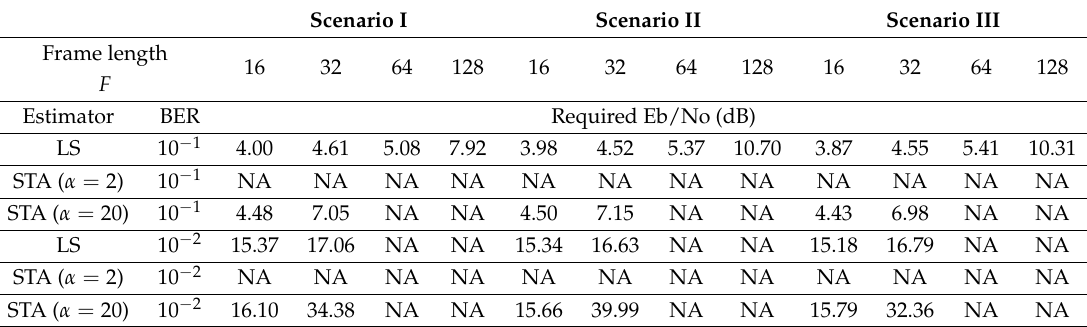
Figure 9. System performance by considering different frame lengths with initial speeds of ν T = ν R = 40 km/h and acceleration components of a T = a R = 20 m/s 2 for Scenario I. Table 6. Required Eb/No levels to attain 10% and 1% BER over Scenarios I, II, and III for different frame lengths by considering initial speeds of ν T = ν R = 40 km/h and acceleration components of a T = a R = 20 m/s 2 (NA—not